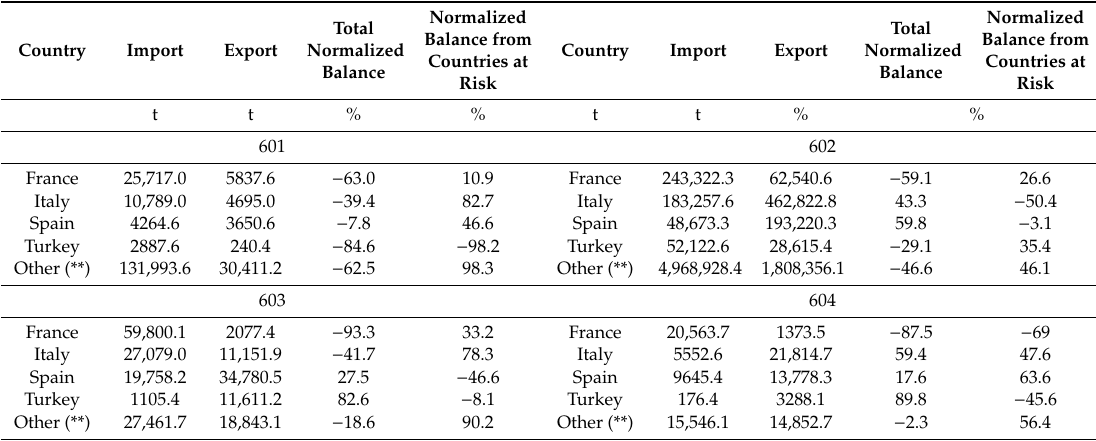
Table 6. Trade indices in the countries of the Mediterranean Basin